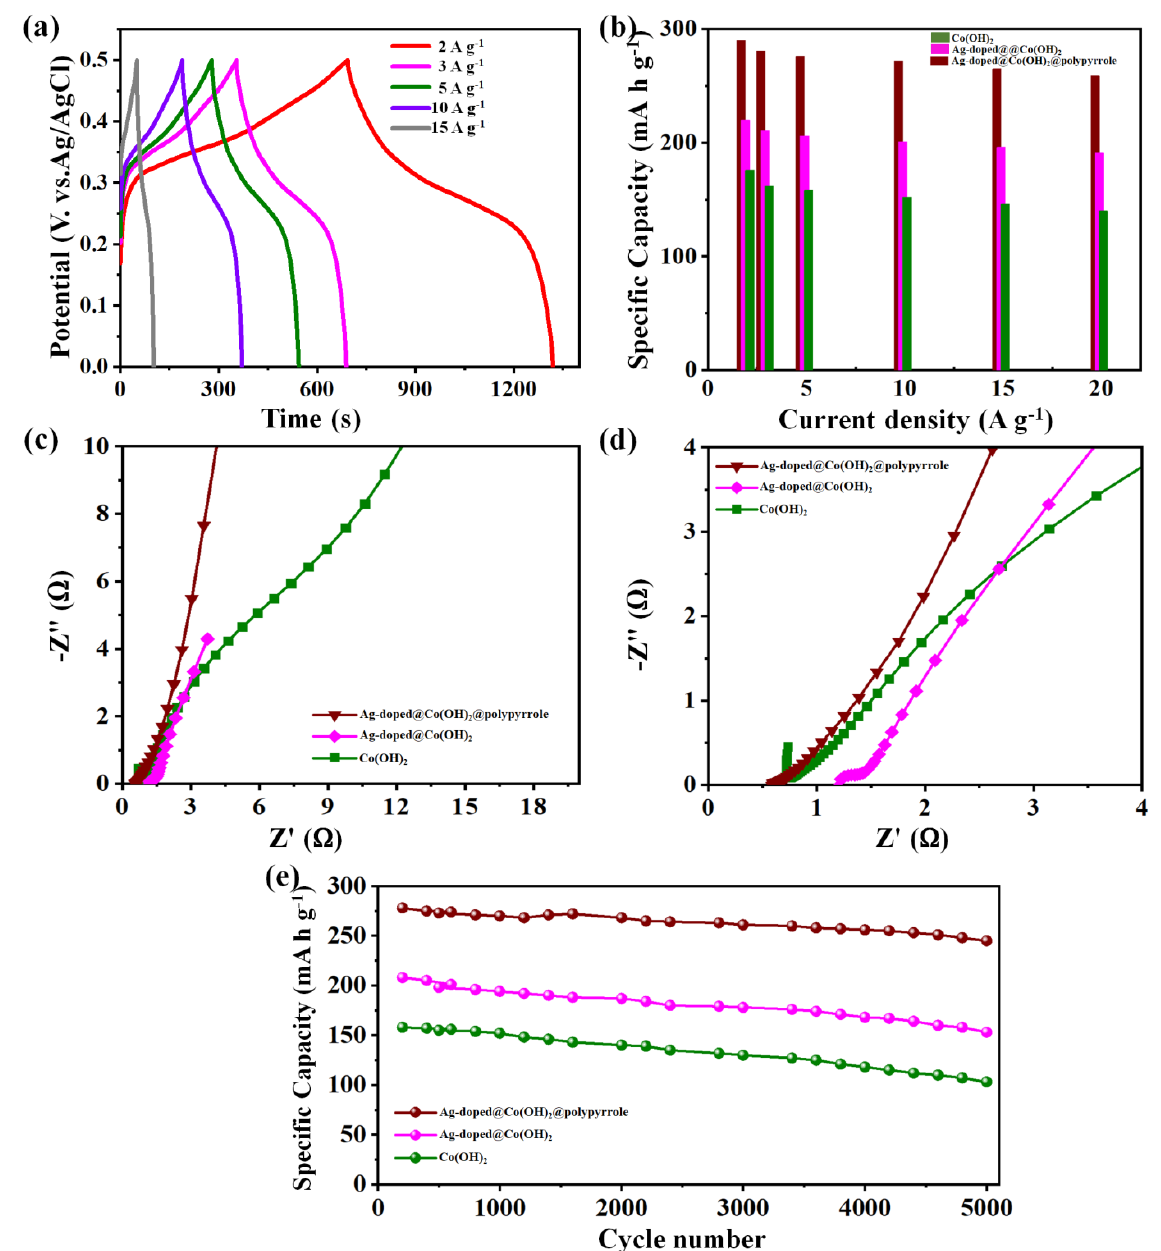
Figure 6. GCD curves of the Ag-doped@Co(OH) 2 @polypyrrole NS electrode at different current densities ( a ); specific capacitance at various current densities ( b ), Nyquist plots ( c ), and zoomed Nyquist plots ( d ), and cyclic stability ( e ) of the pristine Co(OH) 2 , Ag-doped@Co(OH) 2 NPs, and Ag-